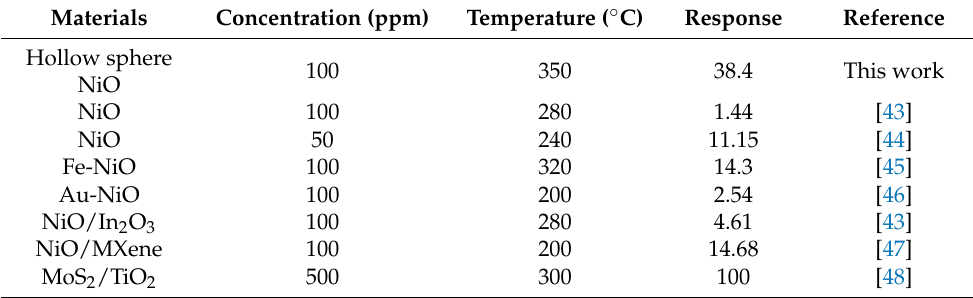
Table 5. Gas sensing performance of ethanol sensors based on different sensitive materials.